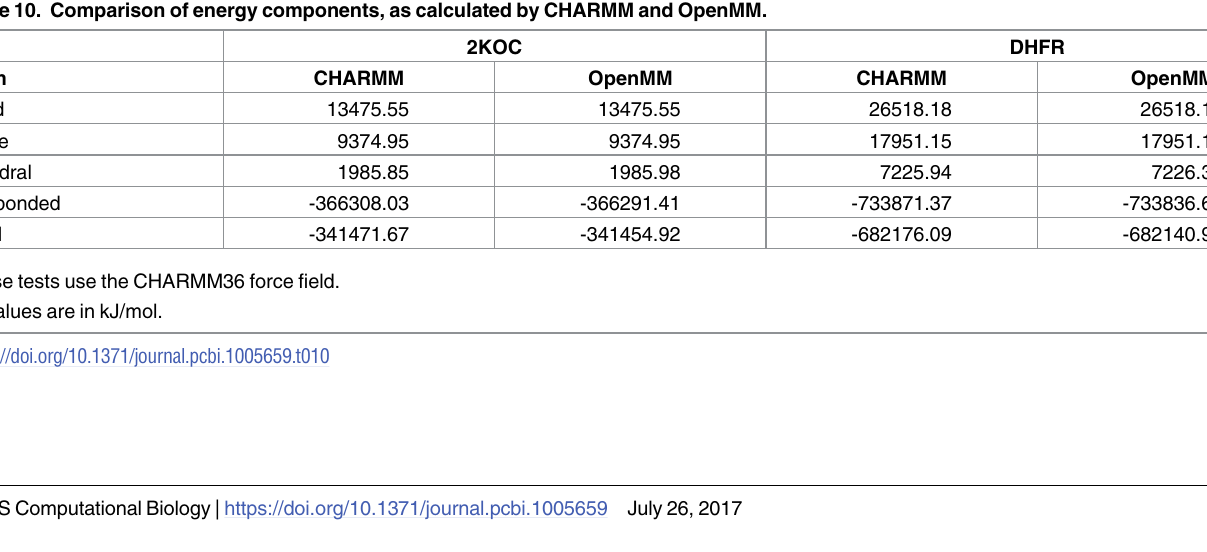
Table 10. Comparison of energy components, as calculated by CHARMM and OpenMM. 2KOC DHFR